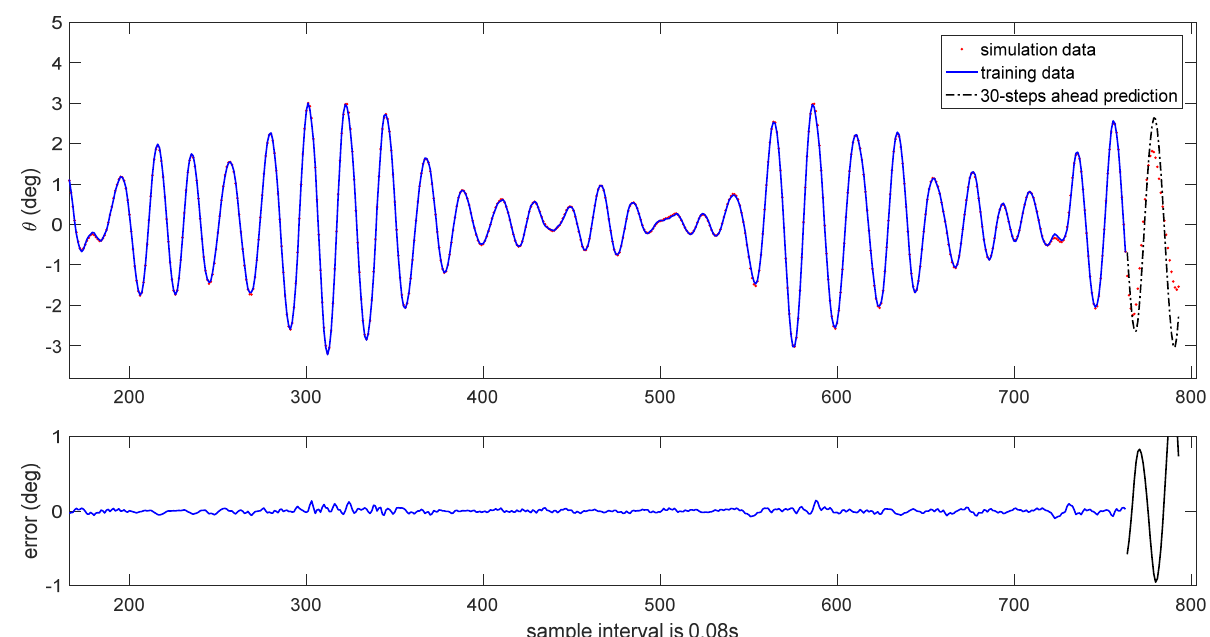
Figure 21. The 30-steps-ahead prediction of pitch motion in irregular waves at the instant k = 763 for the FPSO model. The structure of the CFT-FGWN can be adjusted online over time, and the change process is shown in Figure 22. It can be seen clearly that several significant wavelet terms can characterize the coupled heave-pitch motions in irregular waves, which shows that the CFT-FGWN has a strong nonlinear fitting ability.